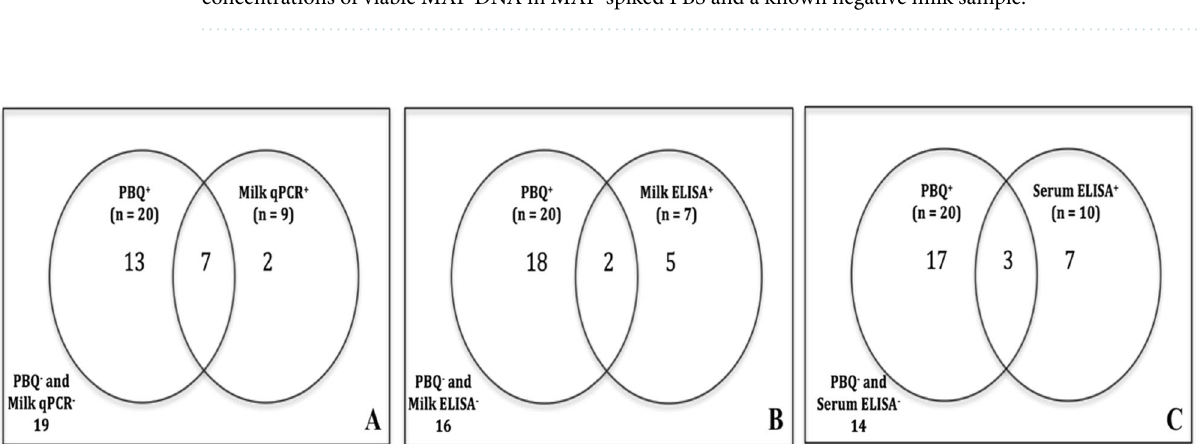
Table 1. Optimization of phage-bead qPCR (PBQ) and threshold cycles (TC) corresponding different concentrations of viable MAP DNA in MAP-spiked PBS and a known negative milk sample.